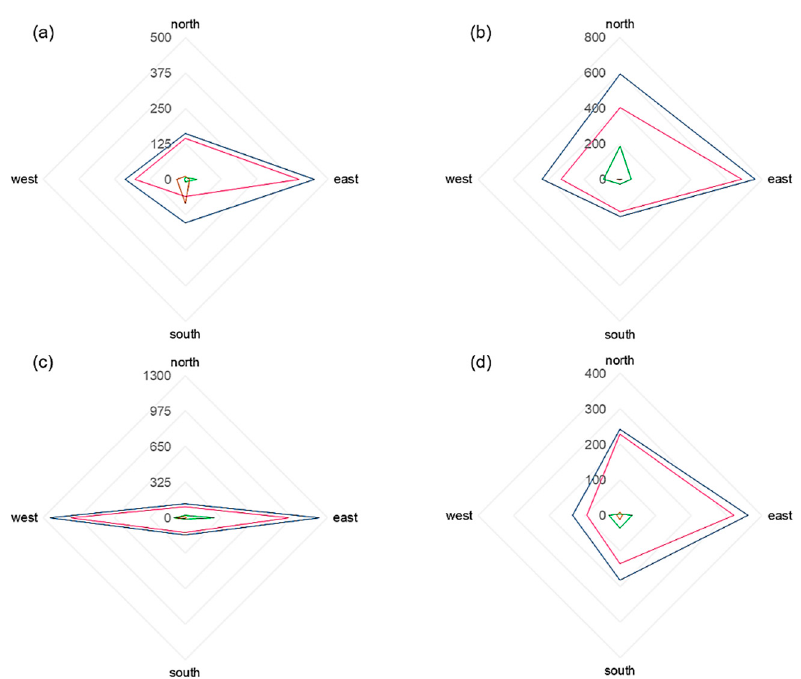
Figure A3. Pollen impaction (pollen grains/cm 2 ) on the vertical slides in 2019 for the pollen seasons; pre-pollen season: 18.03–02.04 (green), main pollen season: 02.04–23.04 (pink), post-pollen season: 23.04–14.05 (brown) and total (blue). For pollen traps 1 ( a ), 2 ( b ), 3 ( c ) and 4 ( d ) at the location Schorndorf.